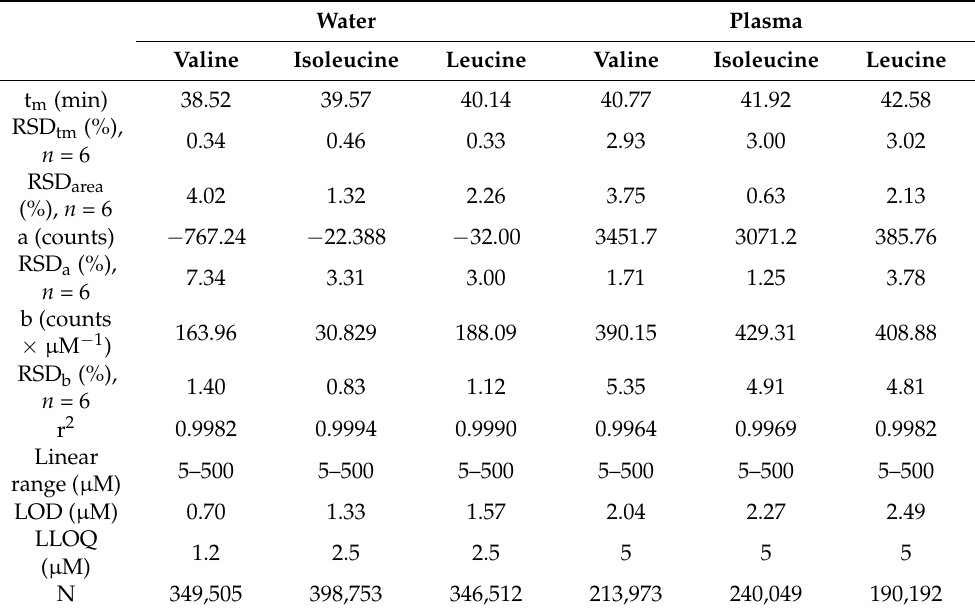
Table 6. Selected operation and validation parameters of the CE-MS/MS method. Water Plasma Valine Isoleucine Leucine